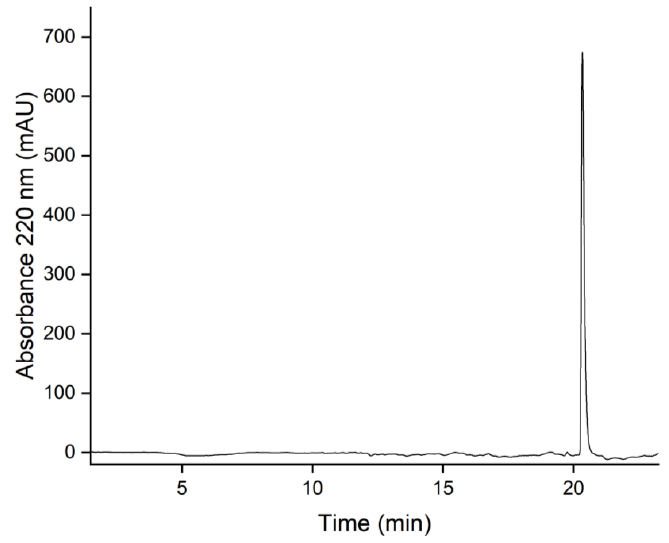
Figure 11. Reversed-phase high-performance liquid chromatography (RP-HPLC) of CCMV after purification by affinity chromatography. 9 µg CCMV was injected and subsequently separated using the following gradients: 0 – 3 min 99% A (H 2 O with 0.2% TFA) and 1% B (ACN with 0.16% TFA); 3 – 23 min 30% A and 70% B; 23 – 40 min 1% A and 99% B, at a constant flow rate of 0.8 mL/min. At 20.7 min, the capsid monomer of the CCMV elutes. No significant peaks of impuri- ties seem to be present in the chromatogram. Purity was calculated by the relative peak ar- eas. The chromatographic analysis software Chromeleon (version 7.2.10.23925) was used for